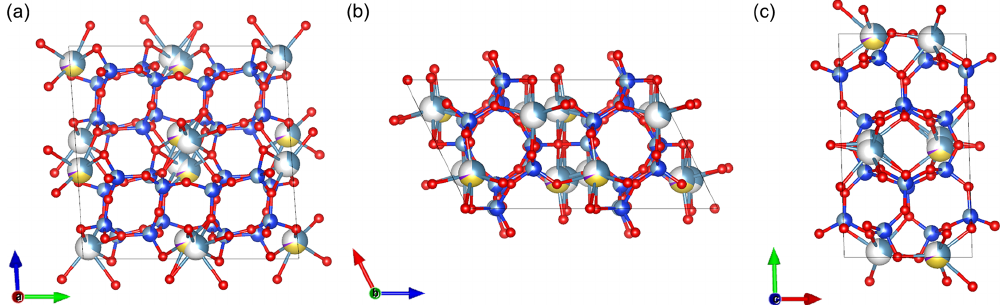
Figure 12. Average structure of labradorite viewed along (a) [100], (b) [010] and (c) [001]. Ca is displayed in light blue, Na in yellow, K in purple, Si in dark blue, Al in grey and O in red. Table 2. Average positions of the atoms in the modulated labradorite structure ( xyz ) with occupancy (occ) and isotropic atomic displacement factors ( U